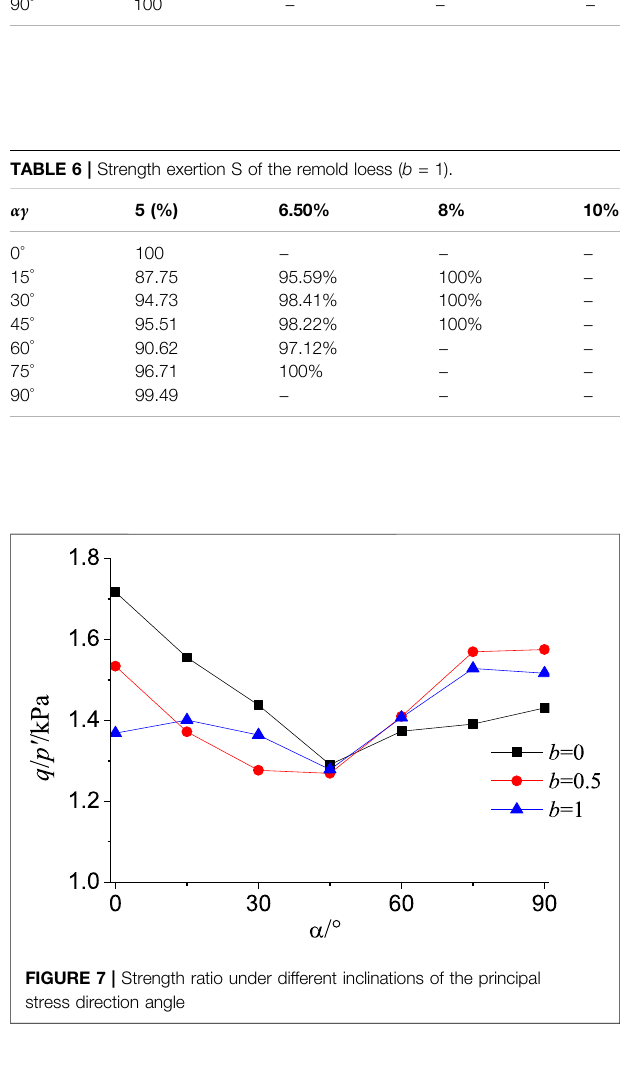
FIGURE 8 | Stress path and non-coaxial behavior of soil